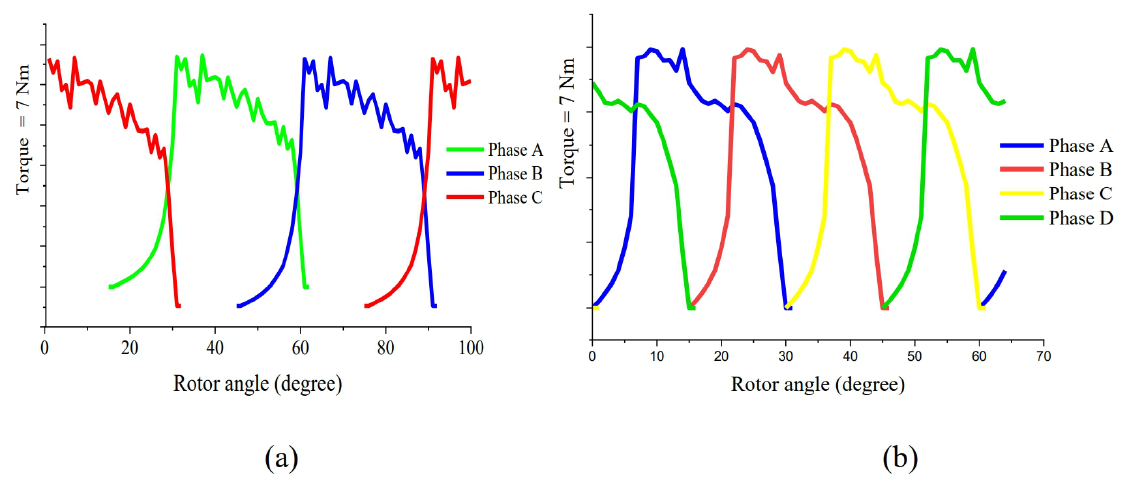
Fig. 12. SRM Torque ripple analysis (a) 6/4, (b) 8/6.